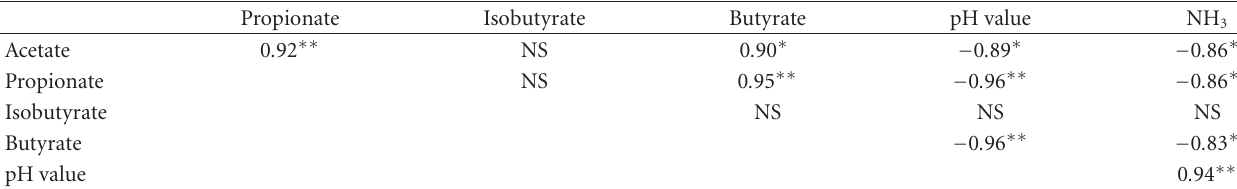
Table 7: Correlations among pH value and contents of N H 3 and short-chain fatty acids after in vitro